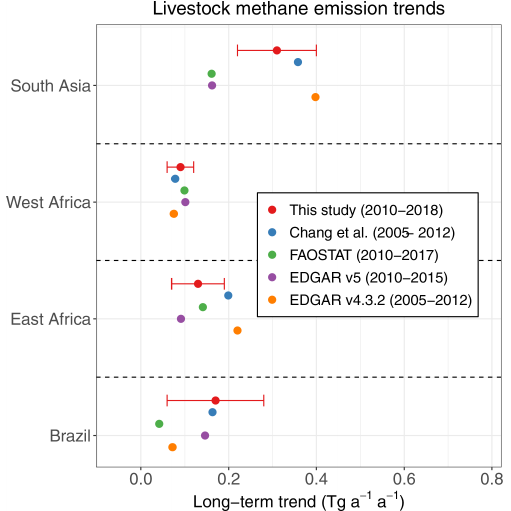
Figure 10. Regional trends in anthropogenic methane emissions from livestock. Our GOSAT inversion results for 2010–2018 (with error standard deviations) are compared to estimates from differ- ent bottom-up inventories over the 2005–2017 period: Chang et al. (2019), FAOSTAT (2020), EDGAR v5 (Crippa et al., 2019), and EDGAR v4.3.2 (Janssens-Maenhout et al., 2017). Results are shown for South Asia (India and Pakistan), West Africa (Nigeria, Côte d’Ivoire, Mali, Niger, Burkina Faso, Cameroon, Ghana, and Benin), East Africa (Ethiopia, Kenya, Uganda, and Tanzania), and Brazil. By assuming zero prior trends in anthropogenic emissions, our inversion does not use trend information in any of these bottom- up inventories; the trends inferred by the inversion are solely from the GOSAT